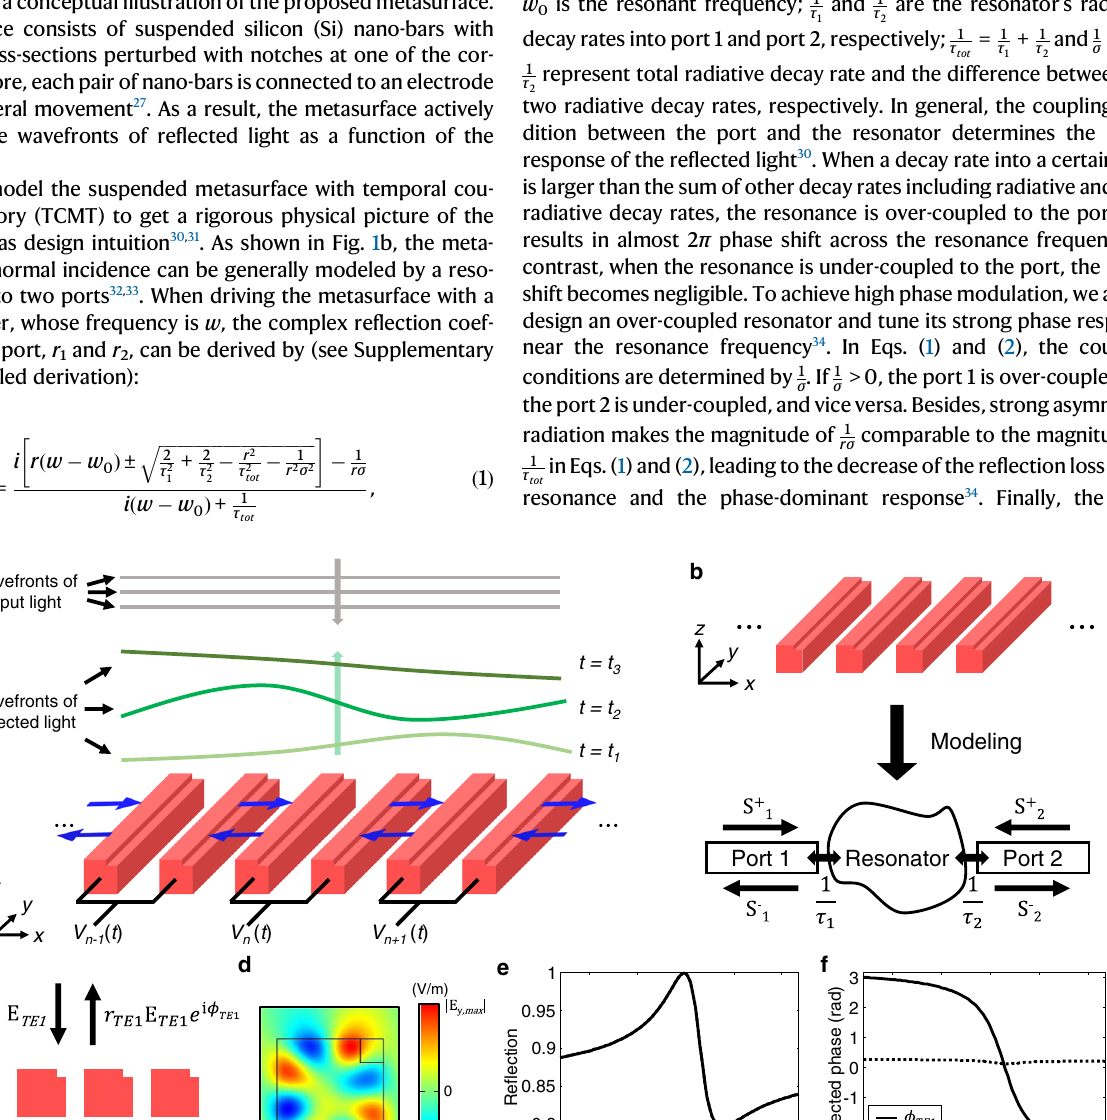
throughtheport1(port2),respectively.Theresonancedecaysintotheport1and and 1 τ , respectively. c Schematic illustration of the asym- 2 with decay rates, 1 τ 1 2 metric metasurfaces showing the perturbed gratings and the notches placed at the right top corners. The TE-polarized light is normally incident from either the top or the bottom side of the metasurface. ∣ r TE ,1 ∣ ( ∣ r TE ,2 ∣ ) and ϕ TE ,1 ( ϕ TE ,2 ) are re fl ected amplitude and phase for the top (bottom) illumination, respectively. d Simulated electric fi eld pro fi le ( y -component, 1531nm wavelength) of the asymmetric metasurface's eigenmode at Γ point. Scale bar denotes 500nm. e , f Calculated re fl ection and re fl ected phase spectra of the asymmetric meta- surfaces for top and bottom illuminations. e The re fl ection spectra are identical forbothilluminationconditions,thusplottedbyonesolidblackcurve. f Solidand dashed curves represent the re fl ected phase spectra for top and bottom illumi- nations,